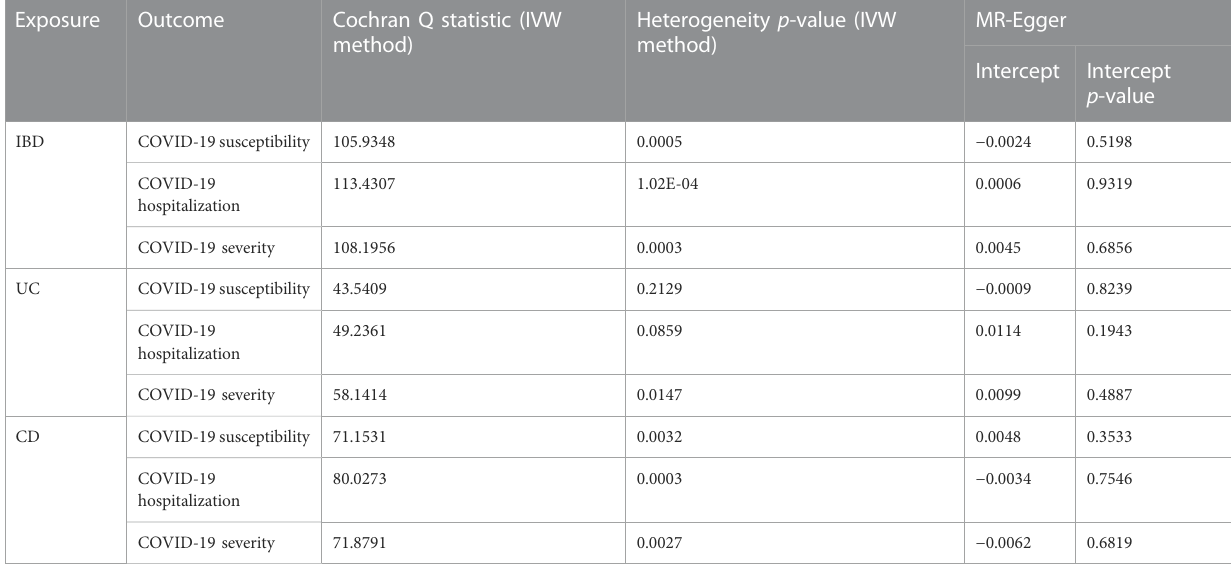
TABLE 1 Heterogeneity and horizontal pleiotropy analyses results.